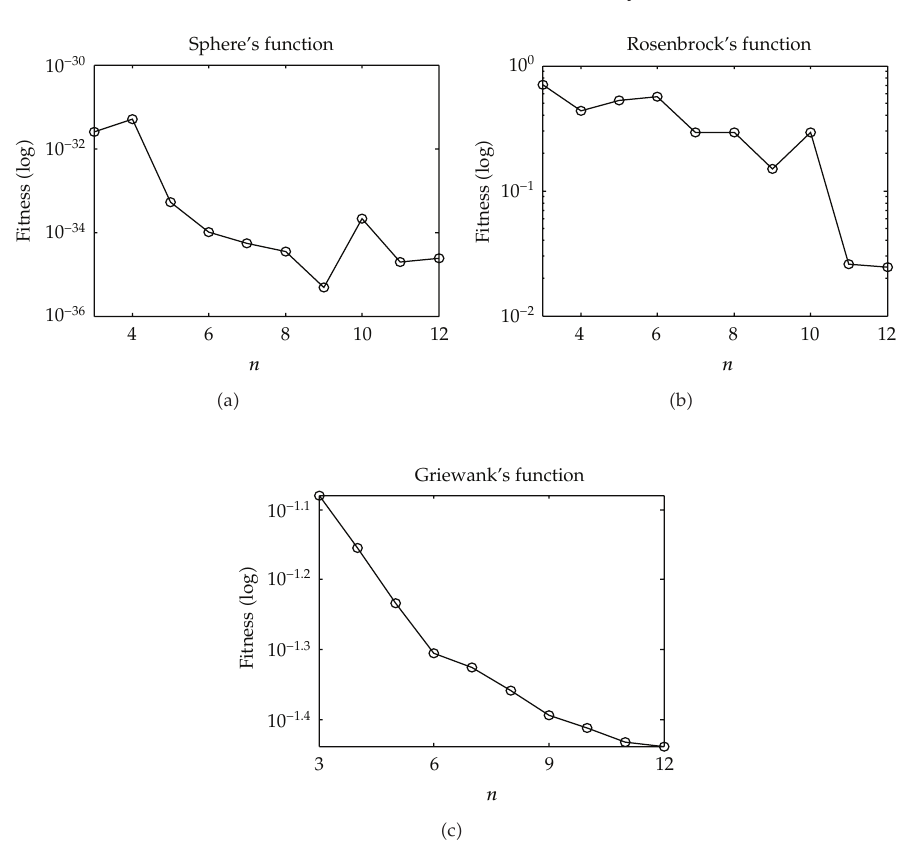
Figure 4: PS 2 O’s results on 3 test functions with di ff erent M